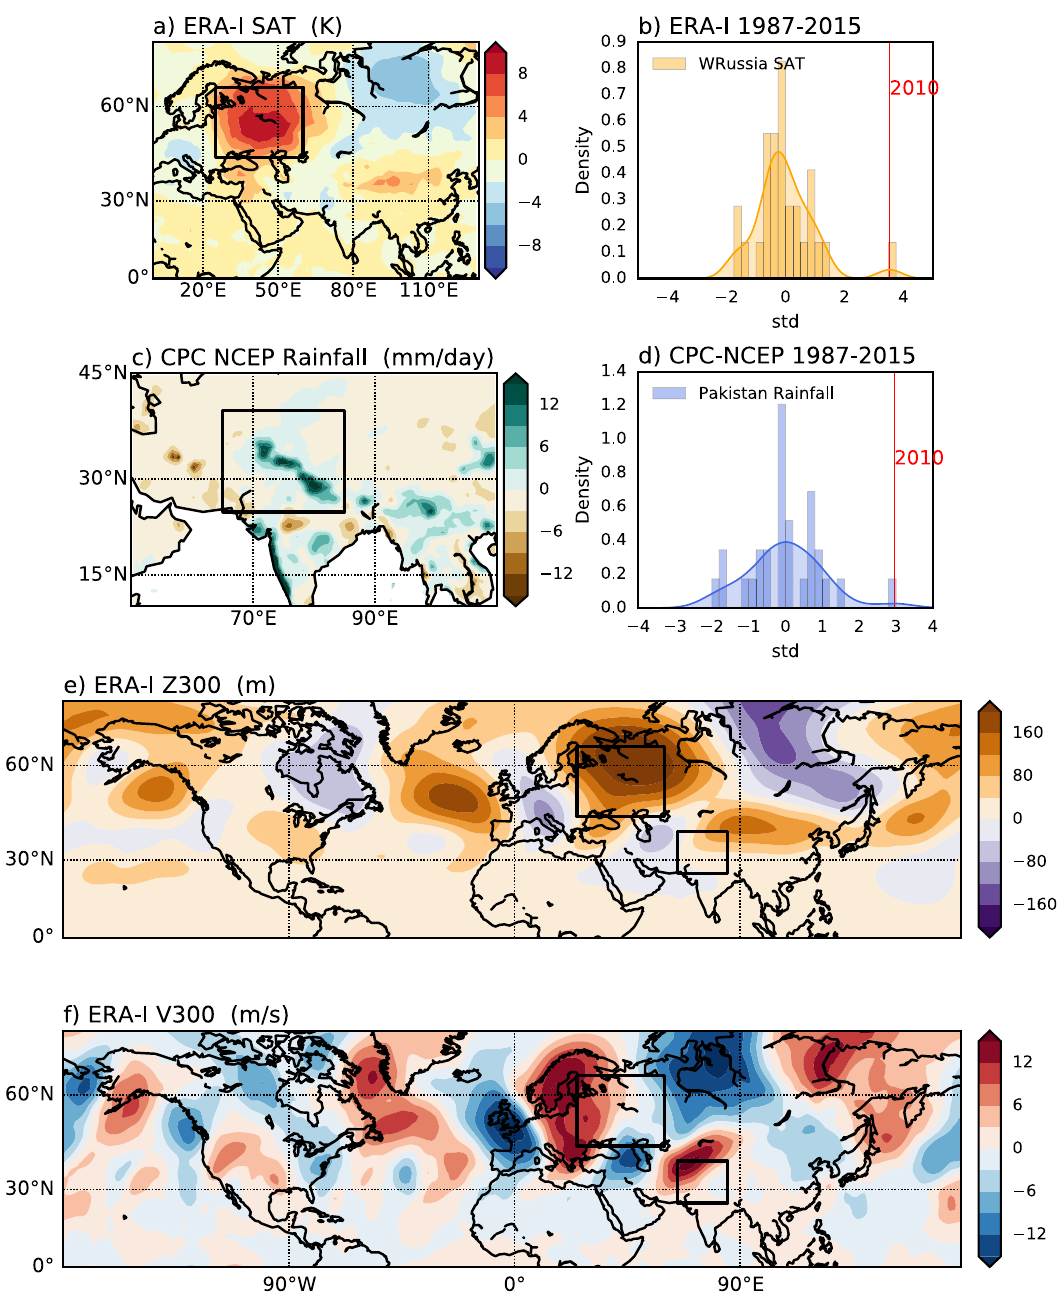
Fig. 1 Observational temperature, precipitation, and circulation anomalies in summer 2010. Panel a : ERA-I surface air temperature at 2 m (SAT) anomalies over Eurasia. Panel b : 1987 – 2015 probability density function for SAT index averaged over the western Russia (WRussia) region, highlighted by a black box in Panel a . Panel c : Same as for panel a but for CPC/NCEP Rainfall anomalies over South Asia. Panel d : probability density function for Rainfall index averaged over the Pakistan region, highlighted by a black box in Panel c . Panel e : Same as for panel a but for ERA-I geopotential height at 300 hPa (Z300) anomalies. Panel f : Same as for panel a but for ERA-I meridional wind component at 300 hPa (V300) anomalies. In both panels b and d vertical red lines highlight 2010 values for SAT and Rainfall respectively. All anomalies are calculated for the period 25.07 – 08.08.2010 based on the 1987 – 2015 climatology of 25.07 – 08.08. The smoothing of the curve is done using a Gaussian kernel to produce continuous density